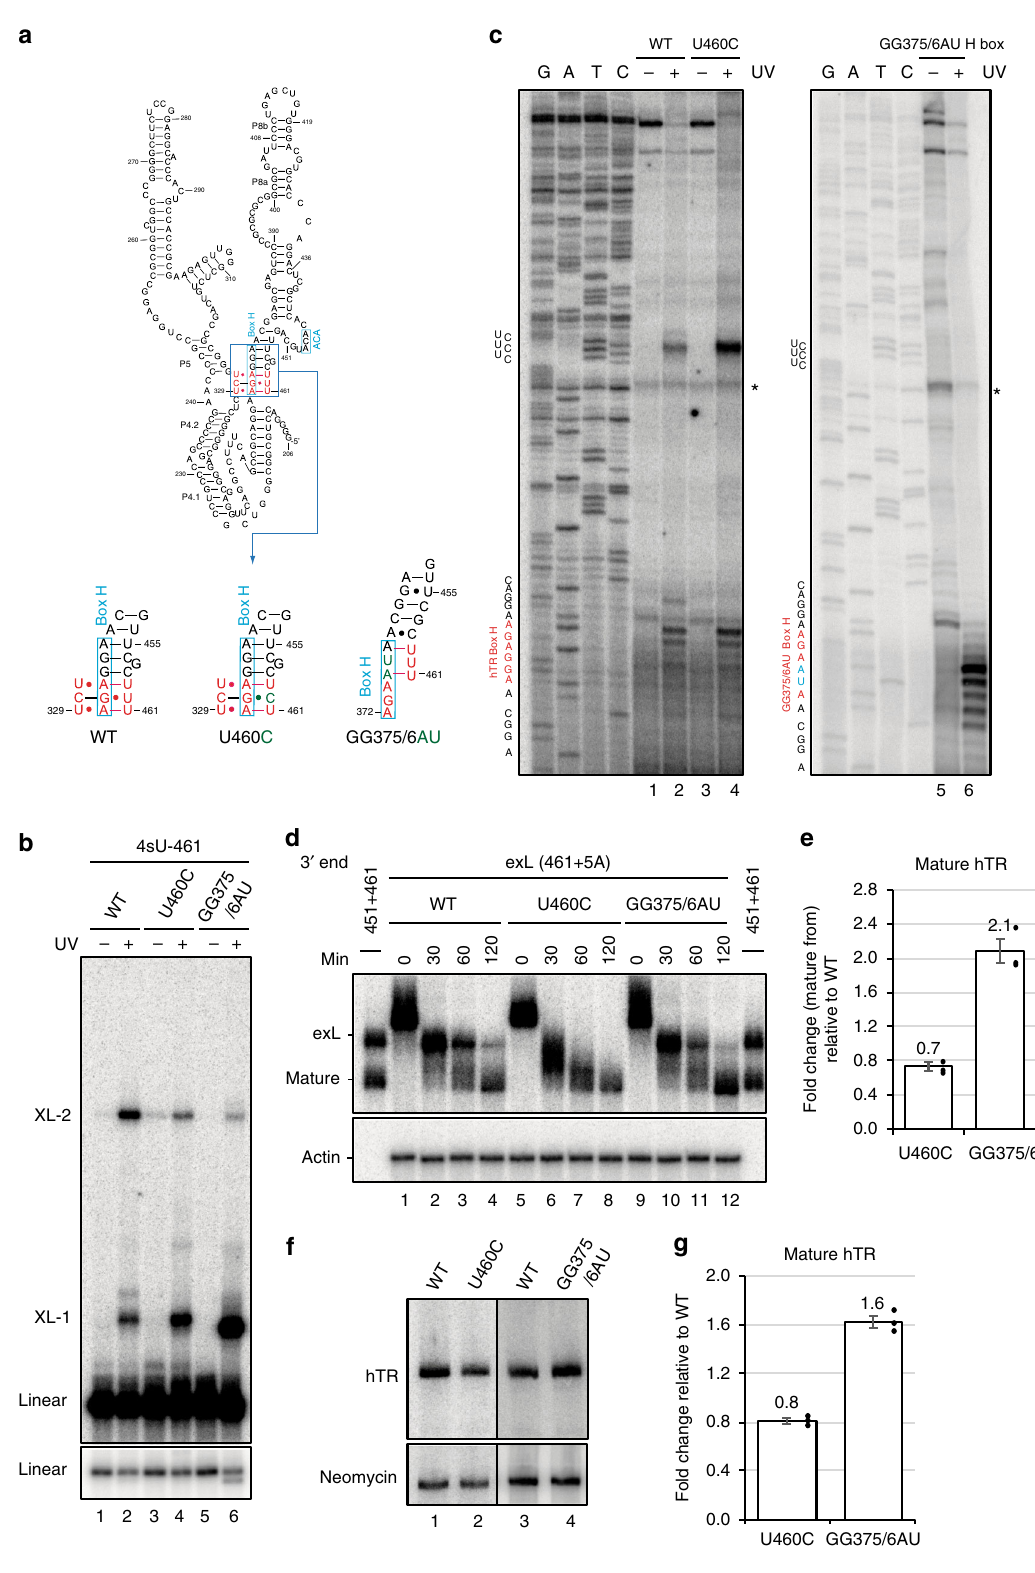
critically important for enzymatic activity and telomere length homeostasis. Here, we have shown that hTR 3 ′ end